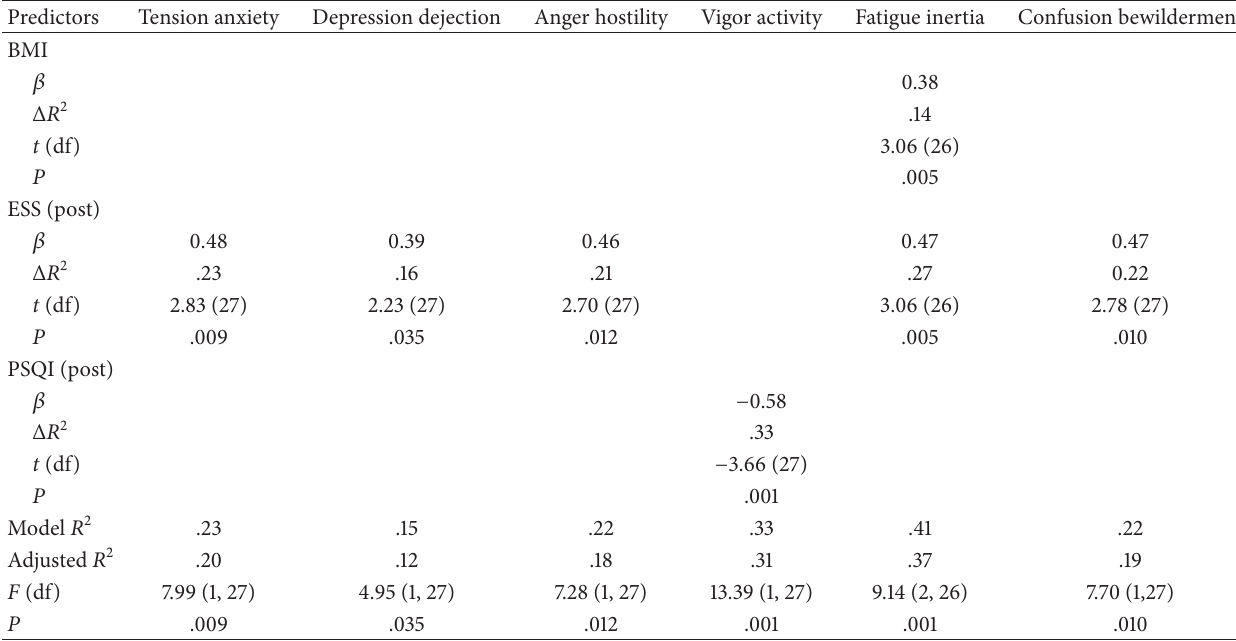
Table 4: Prediction of Profile of Mood States subscales in participants with OSA treated with CPAP using stepwise regression. Predictors Tension anxiety Depression dejection Anger hostility Vigor activity Fatigue inertia Confusion bewilderment